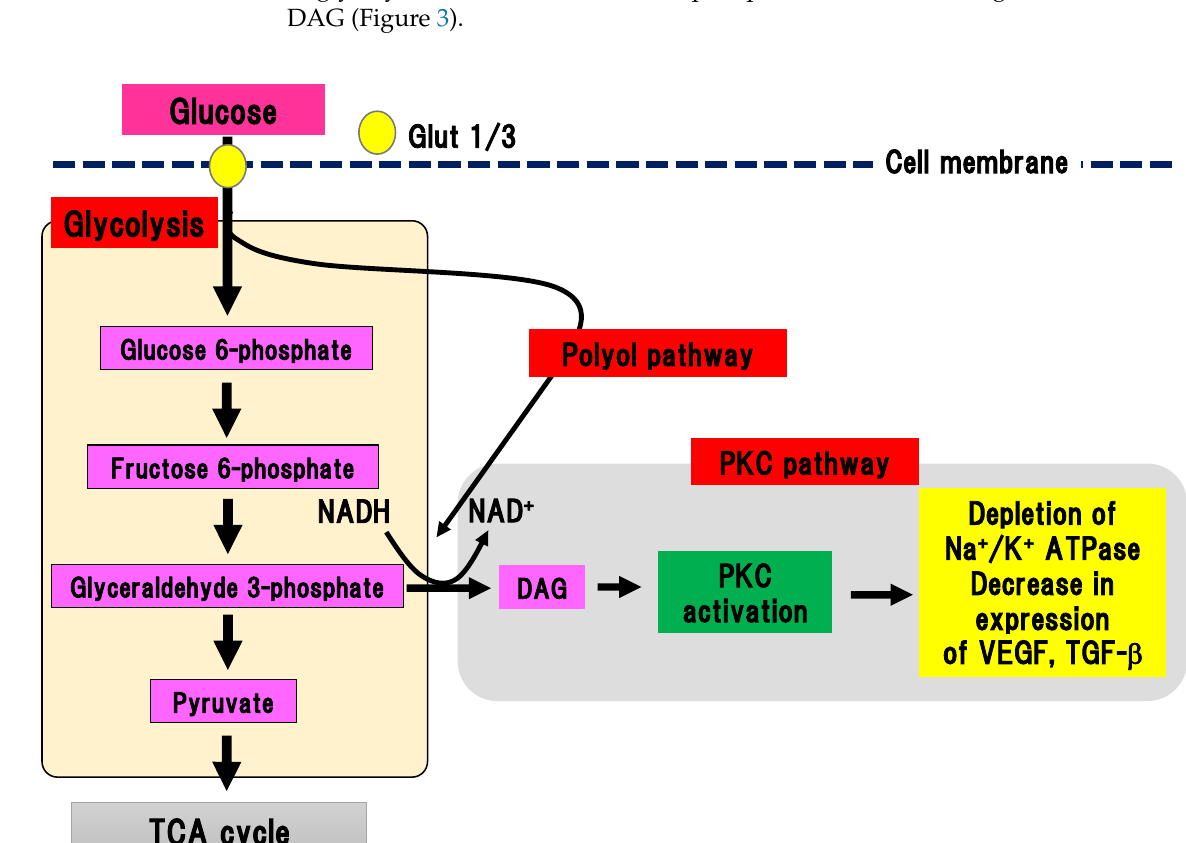
Figure 3. PKC pathway. Glyceraldehyde 3-phosphate is converted to phosphatidic acid, resulting in the accumulation of DAG, which activates PKC. On the other hand, the polyol pathway can activate the PKC pathway by increasing the production of NADH. Glut, glucose transporter; DAG, diacylglycerol; NAD(H), nicotinamide adenine dinucleotide; PKC, protein kinase C; TCA cycle, tricarboxylic acid cycle; TGF- β , transforming growth factor- β ; VEGF, vascular endothelial growth